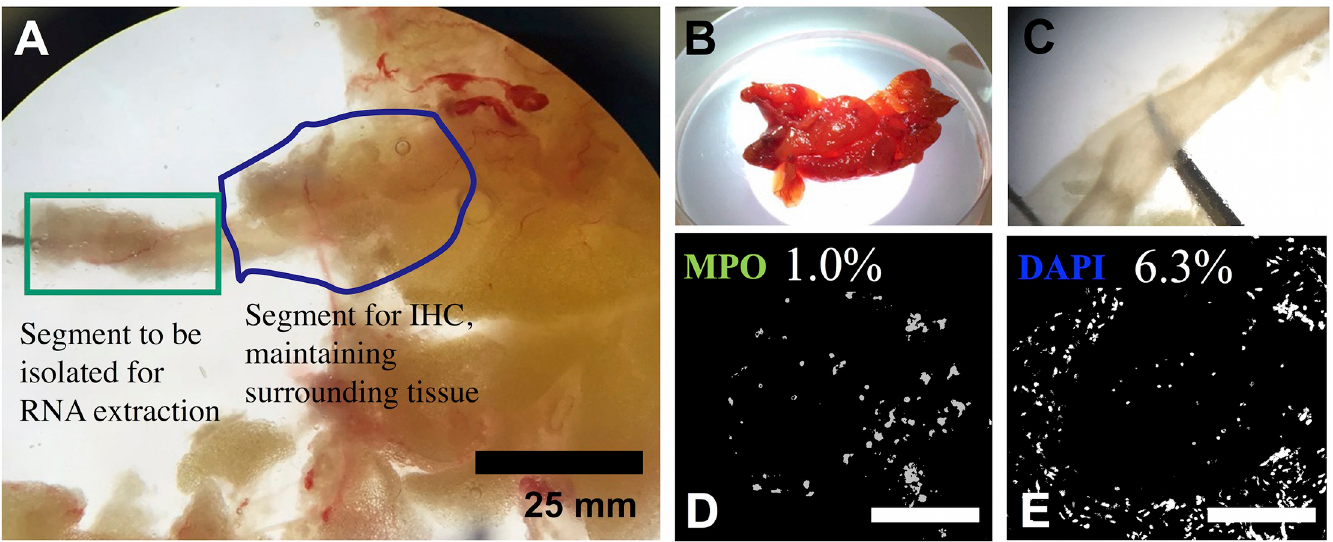
Fig 1. Lymphatic vessel isolation and classification. A. LV isolation technique. B. Tissue sample containing LV. C. Isolated and cleaned vessel for RNA extraction. D&E, Quantification of LVs inflammation was determined using the ratio of MPO staining to cell nuclei (DAPI), in this example 1.0%/6.3% = 0.16, to divide samples into low, medium and high inflammatory states with thresholds of < 3%, 3–10% and > 10% respectively.